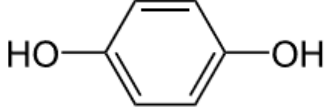
Figure 1. Hydroquinone formula.